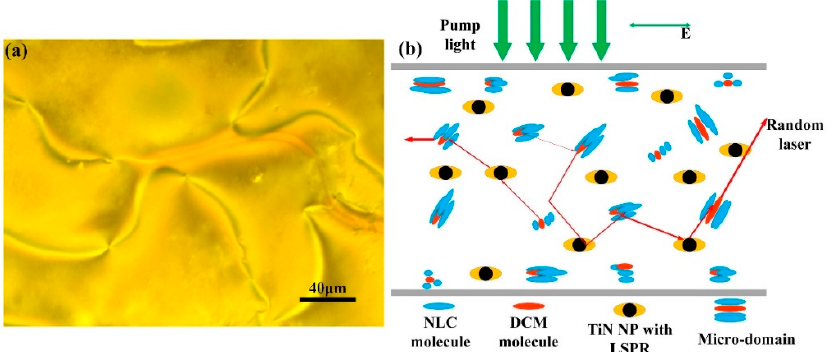
Figure 4. ( a ) The texture of the sample measured by an orthogonal polarizing microscope. ( b ) Schematic illustration of the random laser of the NPDDNLC sample.